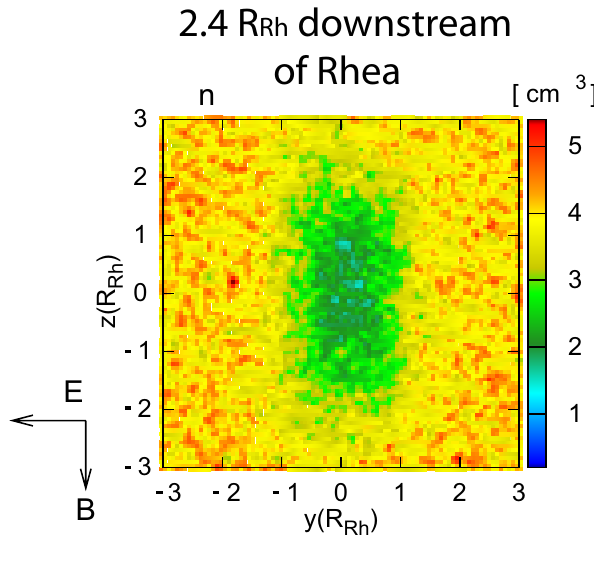
Fig. 4. The asymmetric shape of Rhea’s wake parallel and perpen- dicular to the magnetic field lines. The cut is at ∼ 2.4 R Rh down- stream of Rhea (or at x =1.3 R Rh